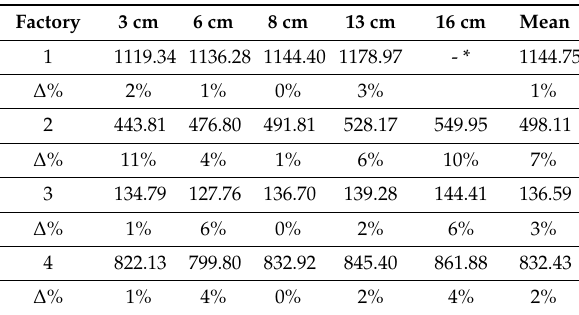
Table 7. Dry density—extensive